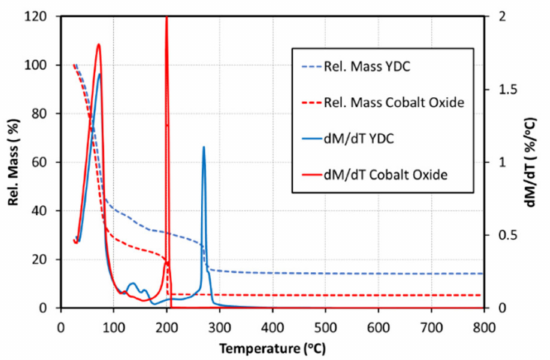
Figure 2. TG curves of 0.75 M YDC and Co x O y precursor inks at a 10 ◦ C min − 1 heating rate in air. The final weight losses were used in thickness calculations. Temperature derivatives from the TG analysis clearly pinpoint the temperature range of mass